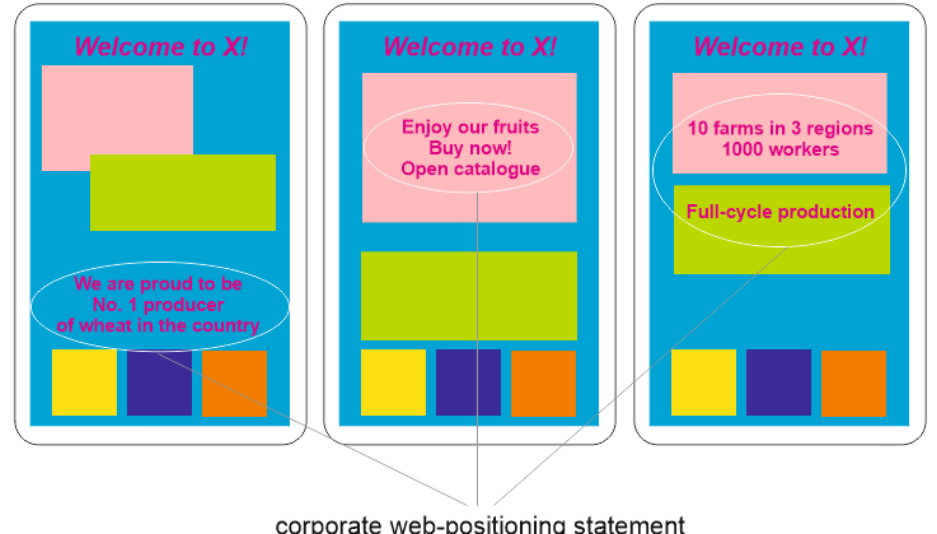
Figure 1. Corporate web positioning statements on idealized webpages.